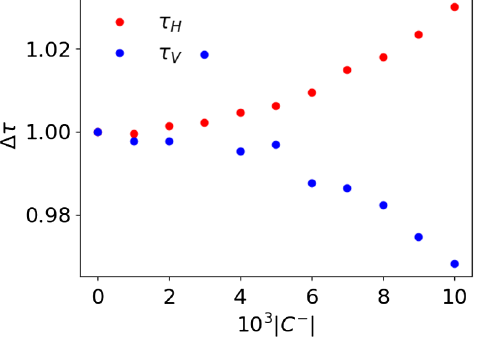
FIG. 7. The change of instability rise time with coupling. The initial starting values were τ H ¼ 5 . 66 s and τ V ¼ 7 . 65 s.